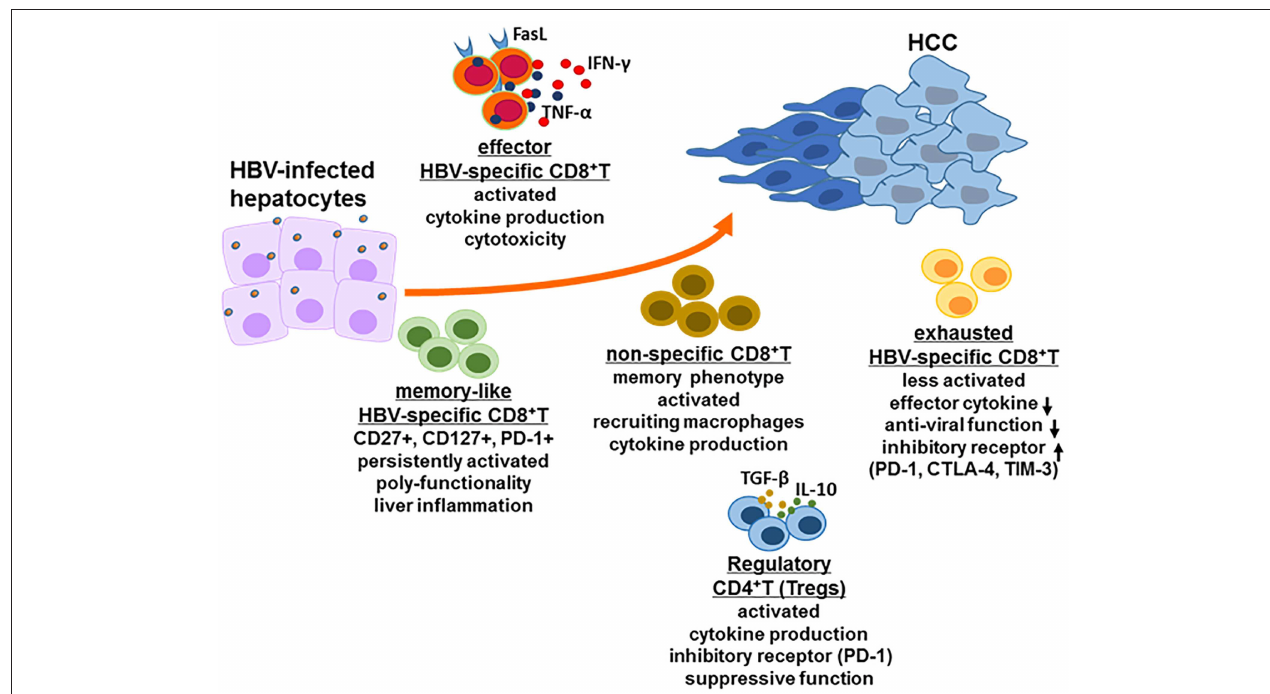
FIGURE 2 | CD8 + T cell response in HBV-related HCC. In the HBV-infected individuals, there are several kinds of CD8 + T cell populations including exhausted HBV-specific CD8 + T cells, HBV core-specific and polymerase-specific CD8 + T cells with long-term memory-like phenotype, effector CD8 + T cells and HBV non-specific CD8 + T cells. The function of each CD8 + T cell population is different but possibly promote the development of HCC together. Additionally, regulatory CD4 + T cells (Tregs) also play a critical role in the stage of HCC for immune escape, for example inducing CD8 + T cell